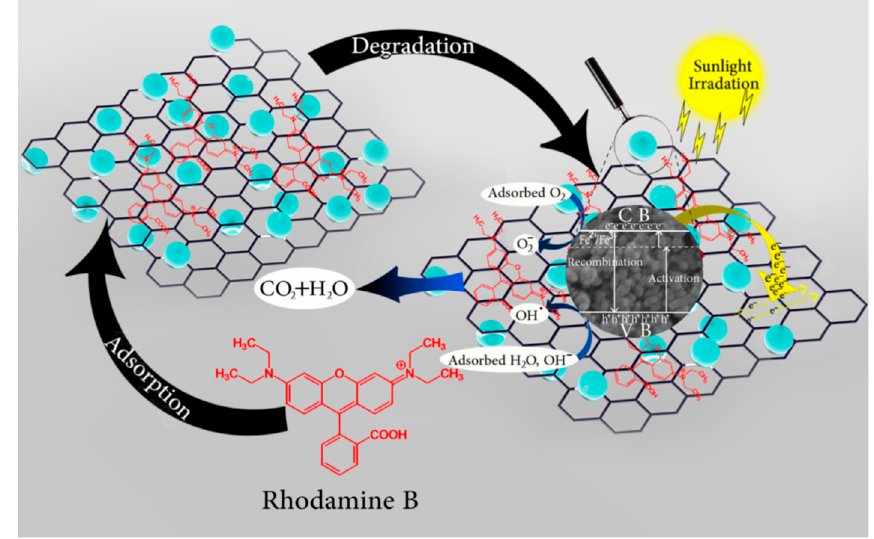
Figure 16. Schematic illustration demonstrating the photocatalytic mechanism of Fe-TiO 2 /rGO catalyst for contaminant under solar irradiation. Adapted with permission from Reference [88]. Copyright (2018) Elsevier.